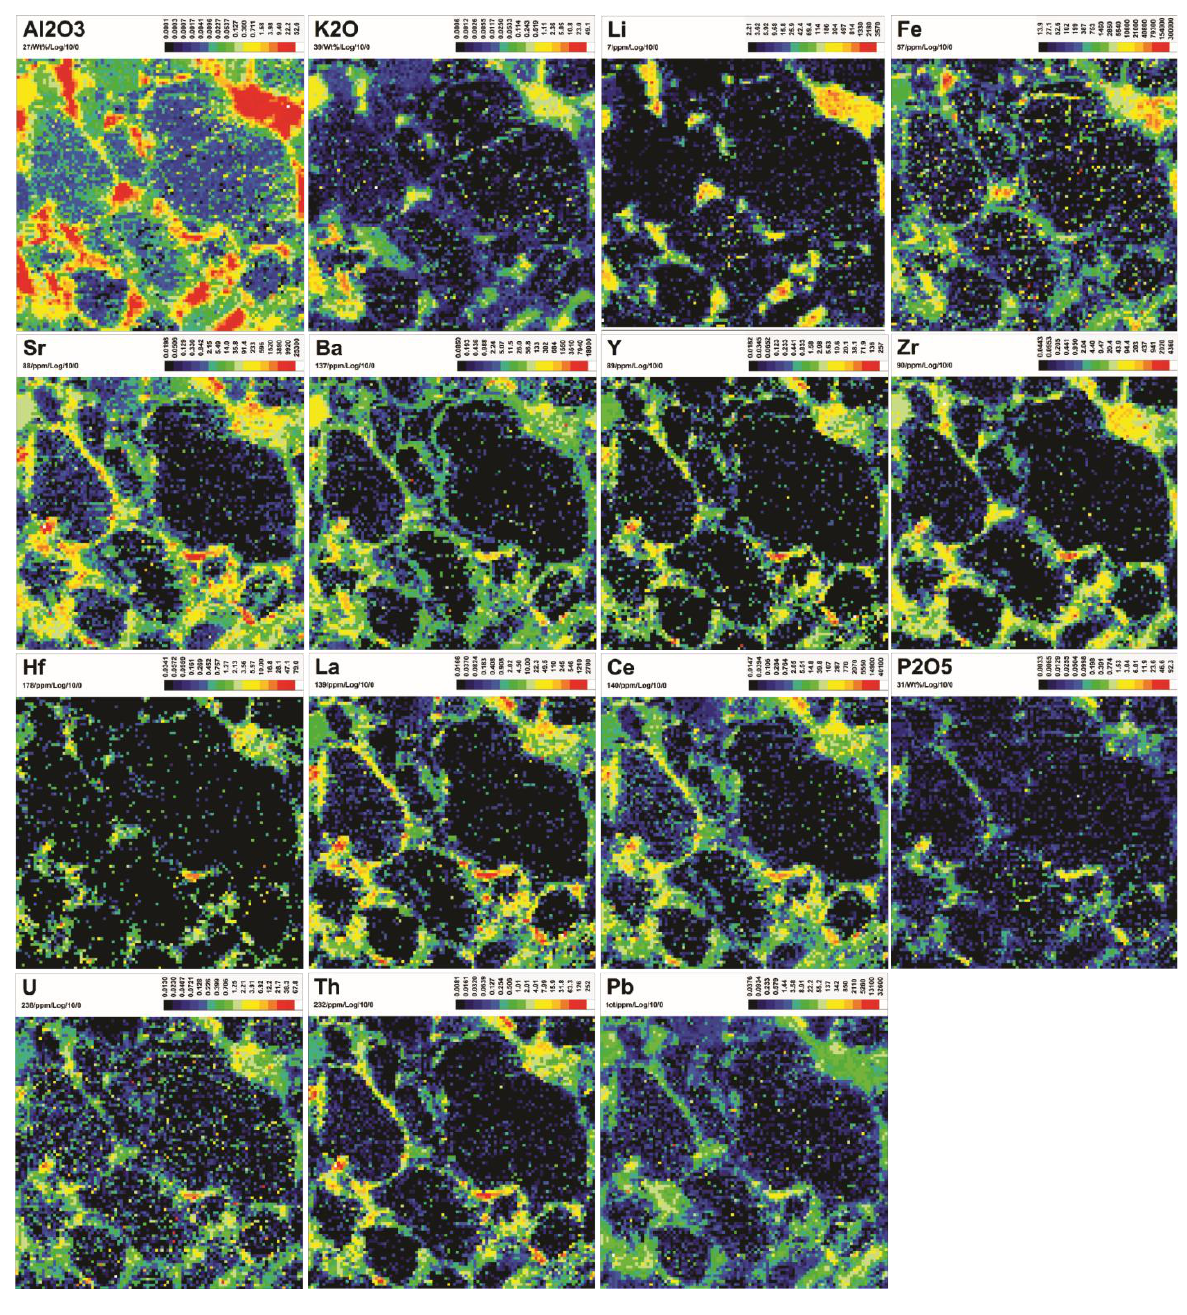
Figure 3. LA-ICP-MS mapping of elements that are strongly and distinctly enriched in the matrix and quartz rim of the sandstone sample (#1425) shown in Figure 2.